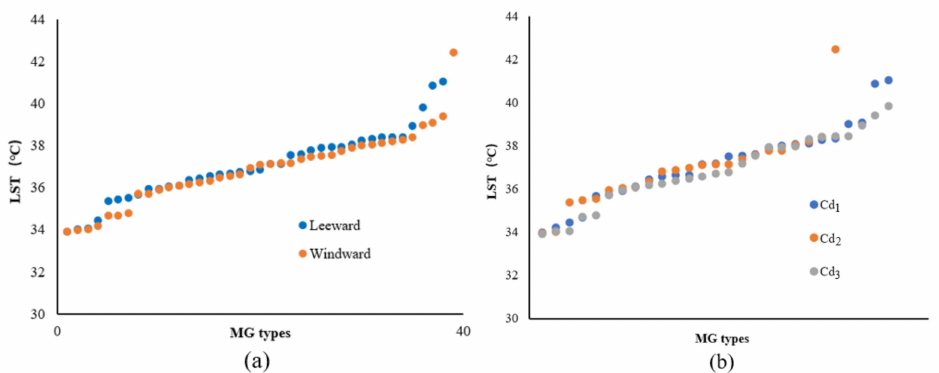
Figure 17. ( a ) Scatter plot of the LST values corresponding to the MG types of green space in different locations (leeward or windward) in the Width-III river zone according to the increasing LST. ( b ) LST values corresponding to the MG types of green space with different Cd grades in the Width-III river zone according to the increasing